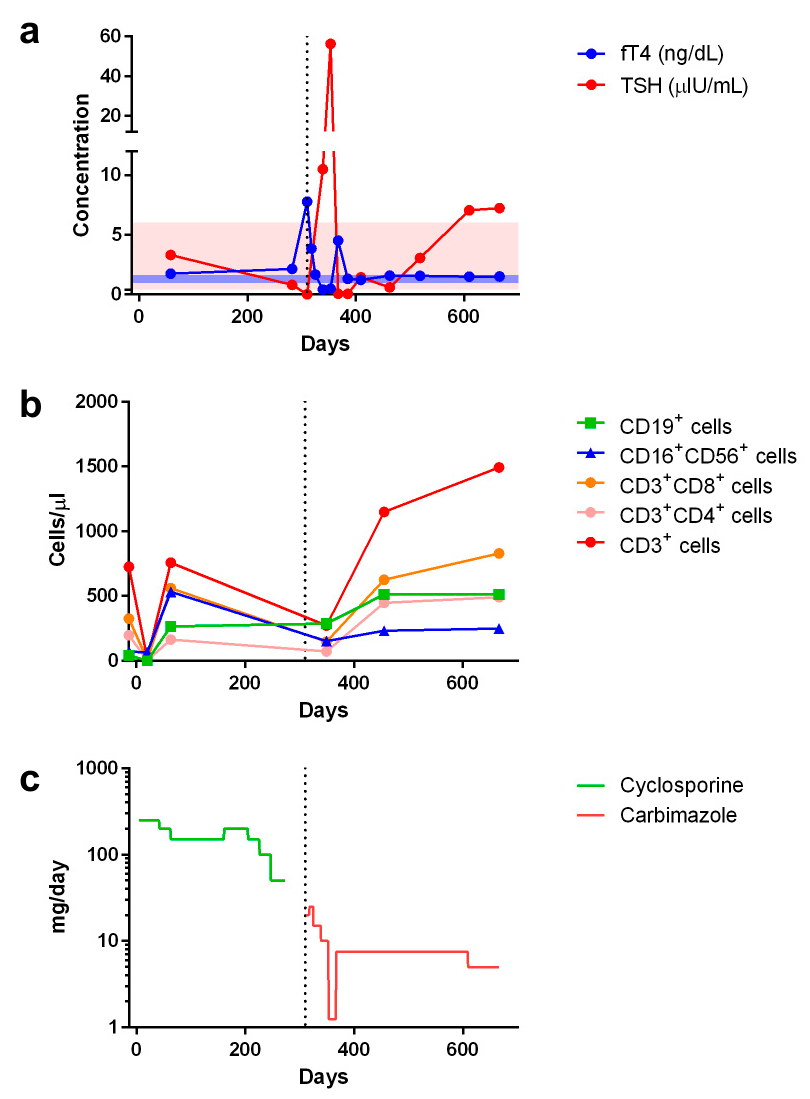
Figure 2. Peri-transplant changes in serum concentrations of ( a ) free thyroxin (fT4) and thyroid stimulating hormone (TSH) as well as ( b ) lymphocyte subset counts in response to ( c ) cyclosporine and carbimazole treatments (showing the comparative dosages). Shaded areas in ( a ) indicate normal ranges of fT4 (blue, 0.925–1.615 ng/dL) and TSH (pink, 0.394–6.00 µ IU/mL). Day 0 indicates the day of peripheral blood stem cell infusion. Vertical dotted line indicates when Graves’ disease was diagnosed and respective treatment started.